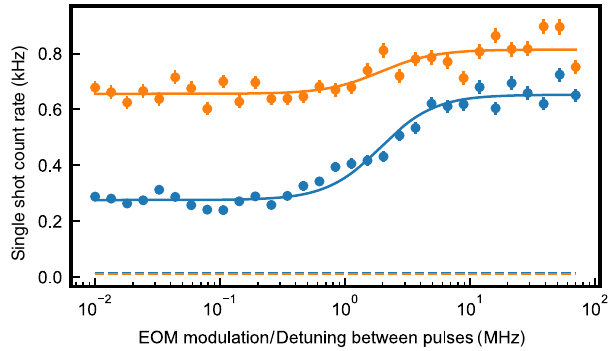
FIG. 15. Comparison of two different techniques to measure the homogeneous linewidth. At the same pulse parameters, the technique introduced in Ref. [11] [blue data and Lorentzian fit with FWHM 3.8(1) MHz] and used in Sec. VI gives a significantly better signal-to-noise ratio than the pump-probe scheme intro- duced in Ref. [24] [orange data and fit with FWHM 3.8(4) MHz]. The y axisshowsthedetected photonsperrepetition,dividedbythe detection time window.